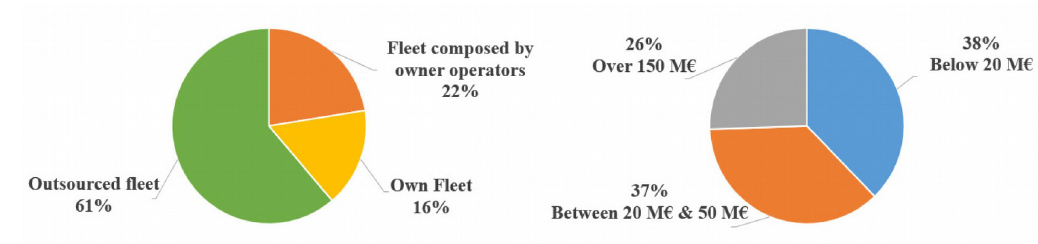
Figure 2. Companies by type of transport fleet and